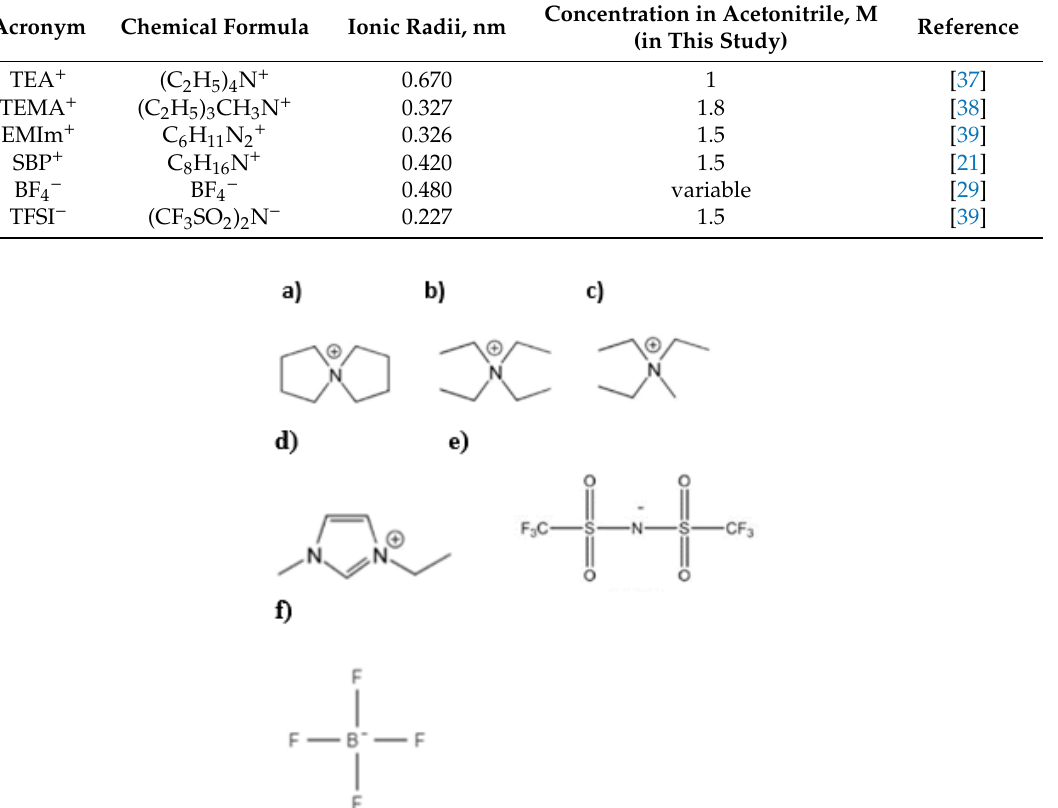
Table 2. Physical properties of electrolytes and ions.